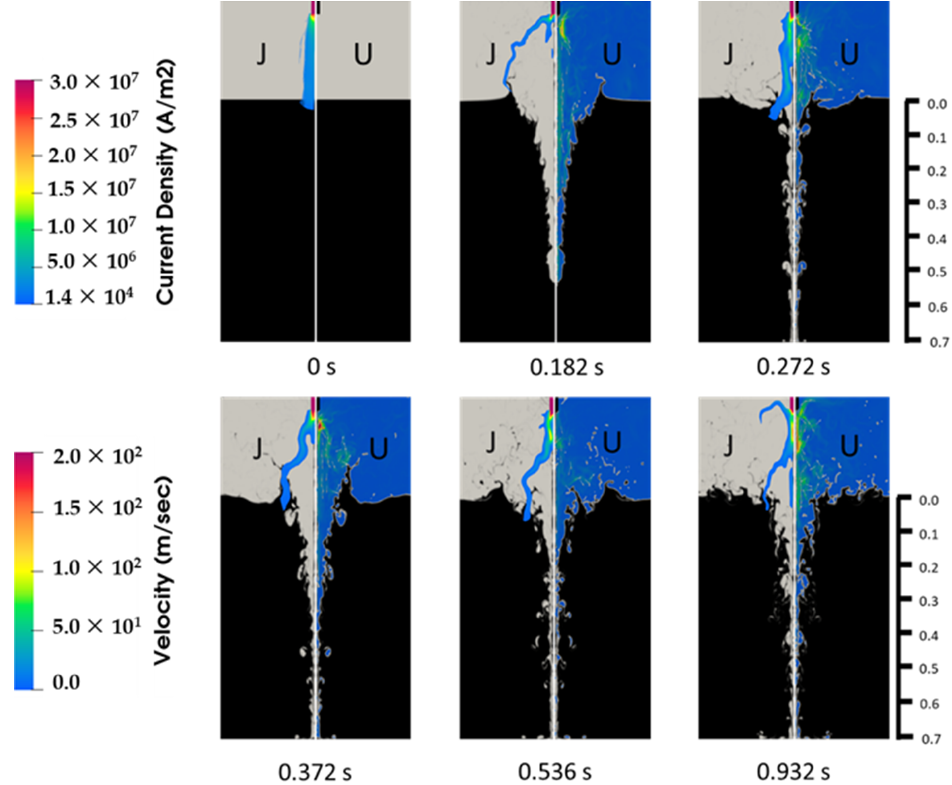
Figure 13. Liquid metal impingement by an arc jet for a total current of 2.0 × 10 1 kA.